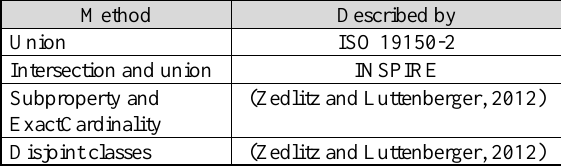
Table 4. Methods for transforming UML